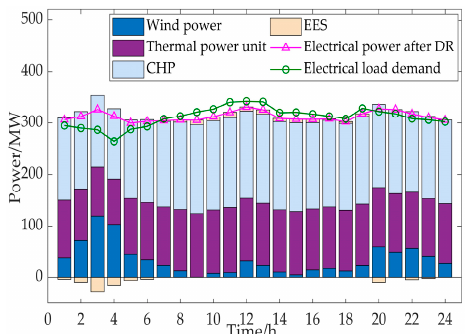
Energies 2019 , 12 , x FOR PEER REVIEW Figure 9. Electric power dispatch result of each unit. Figure 9. Electric power dispatch result of each unit.